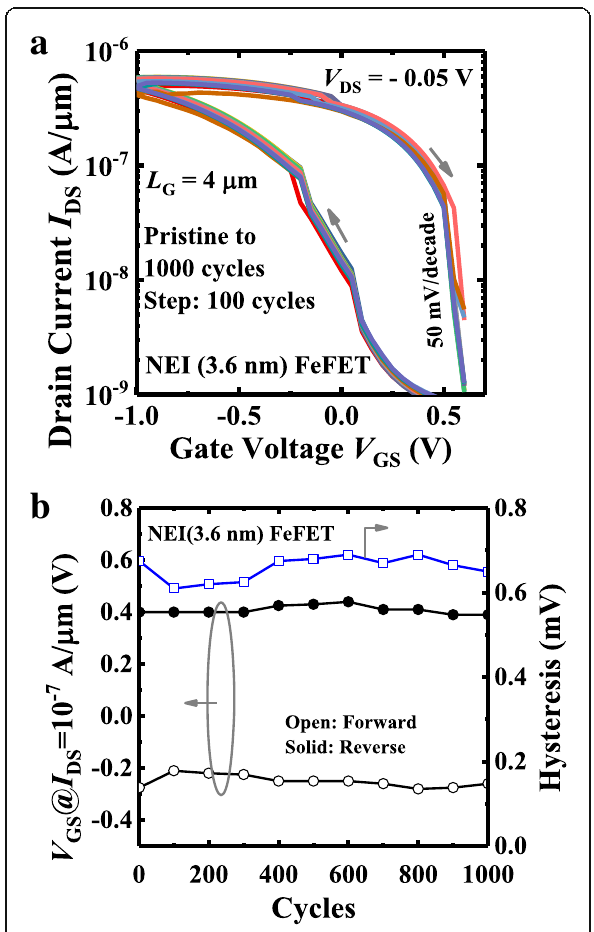
Fig. 11 a Measured I DS - V GS curves for NEI (3.6 nm) FeFET, through 1000 DC sweeping cycles. b DC sweeping endurance